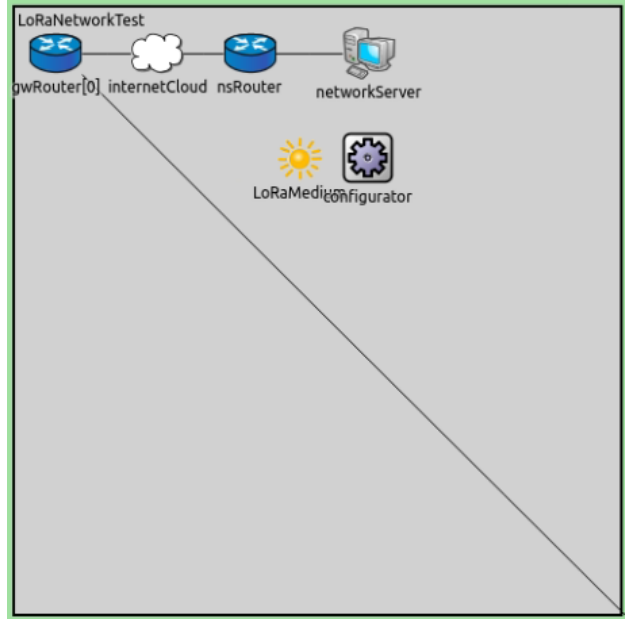
Figure 8. Configuration of the network architecture for LoRa in the FLoRa simulation environment.